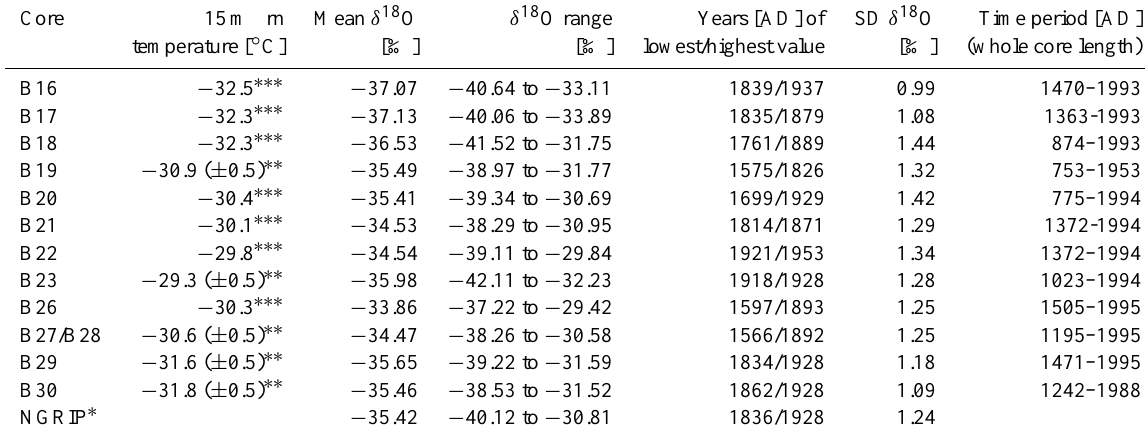
Table 4. The 15m firn temperature, mean annual δ 18 O values for each ice core, the range of the highest and lowest δ 18 O values and the year they occurred as well as the standard deviation (SD) all given for their common time frame (AD1953–1505). Core 15m